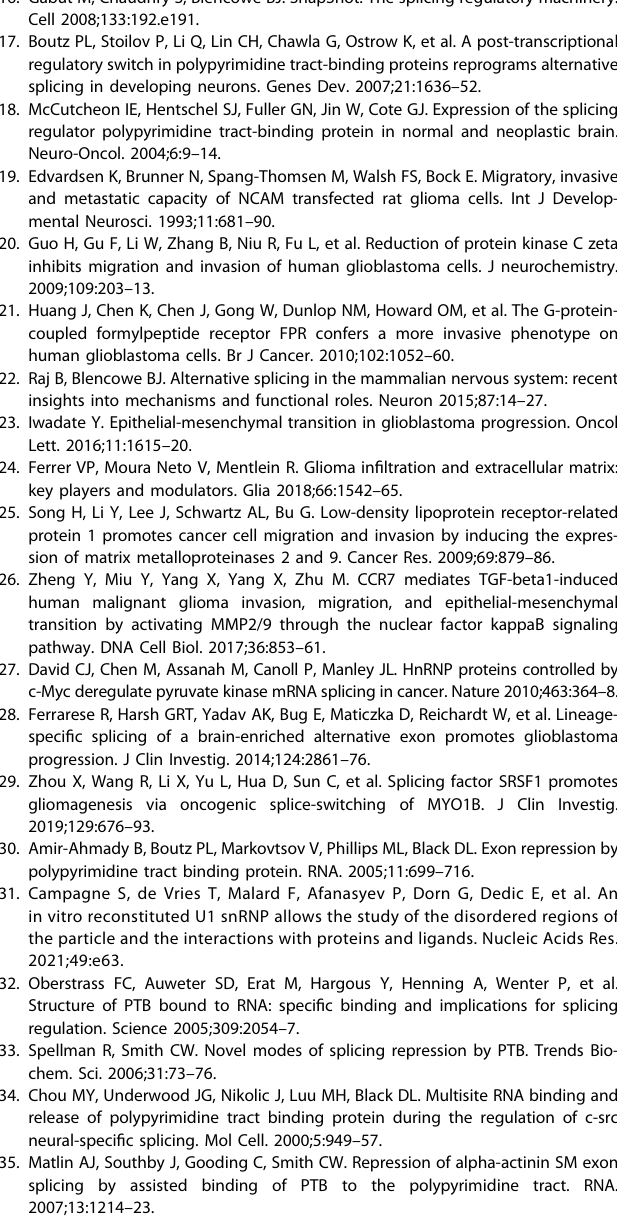
Fig. 7 PTBP1 promoted proliferation, migration, and invasion of glioma cells by regulating alternative splicing of ITSN1 in vivo. A Nude mice injected with silencing PTBP1 or silencing PTBP1 combined with inhibition of ITSN1-L LN229 cells. The images shown represent results for 7 mice. Red and blue dotted lines indicated the location and size of the tumors. B Tumor growth curve in indicated nude mice. values were expressed as mean ± SD (two-way ANOVA, ns, no signi fi cance). C The representative images show xenograft tumor tissues isolated from the nude mice. D Representative images of hematoxylin-eosin staining (left, scale bars, 200 μ m), the frequency of xenograft invasion in mice was analyzed quantitatively (right), P value was calculated using the chi-square test. *** P < 0.001. E Representative immunohistochemical staining with anti-Ki67 in xenograft tumor sections (left, scale bars, 200 μ m), the percentage of positive staining cells with the expression of Ki67 in xenografts were quanti fi ed (right). F Nude mice injected with silencing PTBP1 or silencing PTBP1 combined with overexpression of ITSN1-S LN229 cells. The images shown represent results for 8 mice. Red and blue dotted lines indicated the location and size of the tumors. G Tumor growth curve in indicated nude mice, values were expressed as mean ± SD (two-way ANOVA, *** P < 0.001). H The representative images show the xenograft tumors isolated from nude mice after sacri fi ced. I Representative images of hematoxylin-eosin staining in indicated tumor sections (left, scale bars, 200 μ m), the frequency of xenograft invasion in mice was analyzed by quantitatively (right), P value was calculated using the chi-square test. *** P < 0.001. J Immunohistochemistry for Ki67 of representative images in tumor sections (left, scale bars, 200 μ m), the expression of Ki67 was quanti fi ed with percentage of Ki67-positive cells to the total cells in tumor sections (right) (two-tailed Student ’ s t test, *** P < 0.001). K A proposed schema involving PTBP1 enhanced the inclusion of ITSN1 exon 30 to promote glioma progression. PTBP1 enhanced ITSN1 exon 30 inclusion through the binding of poly-pyrimidine sequences of exon 30, and the expression of ITSN1-S increased as well as the expression of ITSN1-L decreased, which promoted glioma